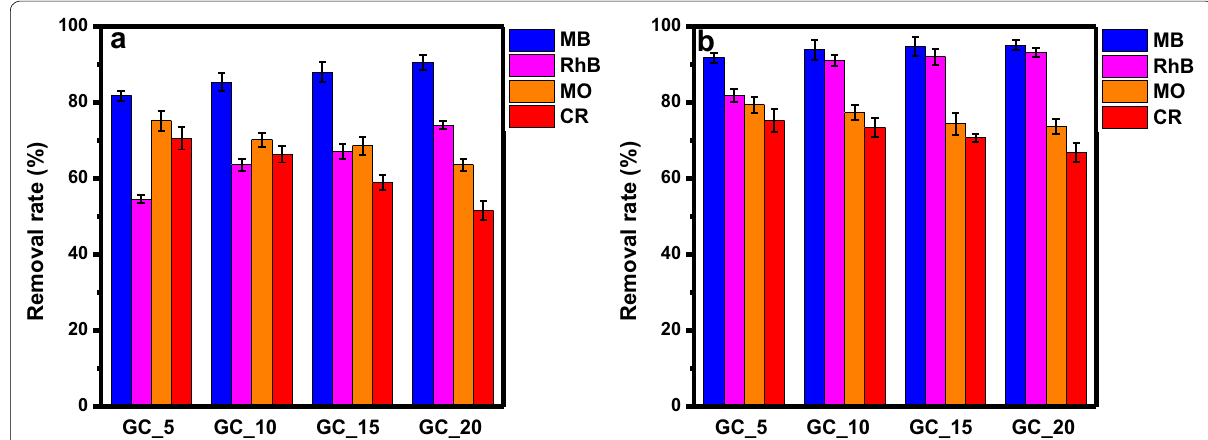
Fig. 9 Dye removal rate before and after filtration through the GCCHCs via a direct filtration and b filtration after 24 h of immersion